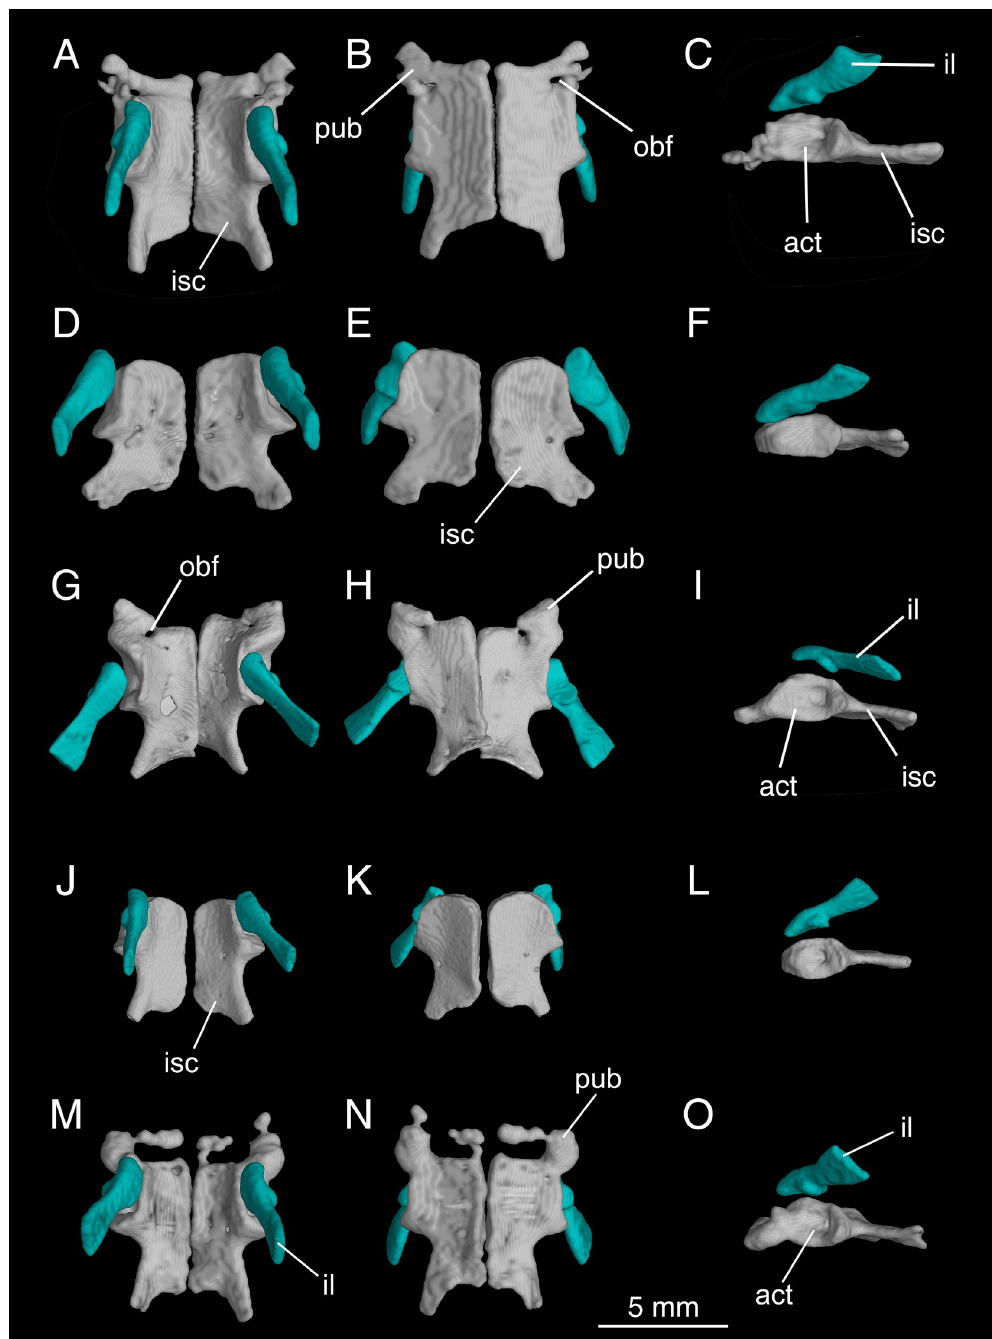
Fig 11. Micro-CT rendered reconstructions of the pelvic girdle of Batrachuperus yenyuanensis in dorsal (left column), ventral (middle column) and left lateral (right column) views. CIB 14514 (A–C), CIB 16999 (D–F), CIB 17302 (G–I), CIB 17307 (J–L) and CIB 72592 (M–O). Note partly ossified pubis in CIB 14514 (A–C), CIB 17302 (G–I), and CIB 72592 (M–O). CIB 14514 from Maoniudui, Dechang County; CIB 16999 from Shenguozhuang, Yuexi County; CIB 17302 and CIB 17307 from Shuangertang, Yanyuan County; CIB 72592 from Tuowu, Mianning County.